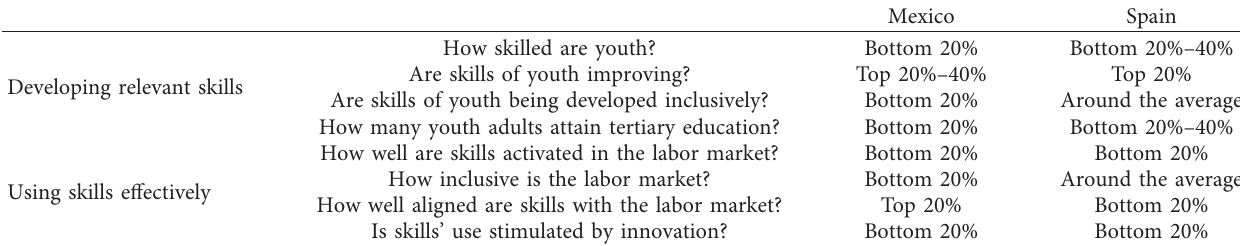
Table 1: Indicators across pillars of the skills